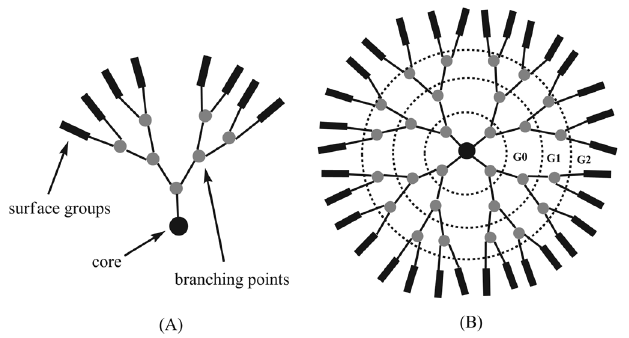
FIGURE 2 - Schematic picture of dendrons (A) and dendrimer (B). Gn (n=0–2) represent dendrimer generations: generation 0 to 2.